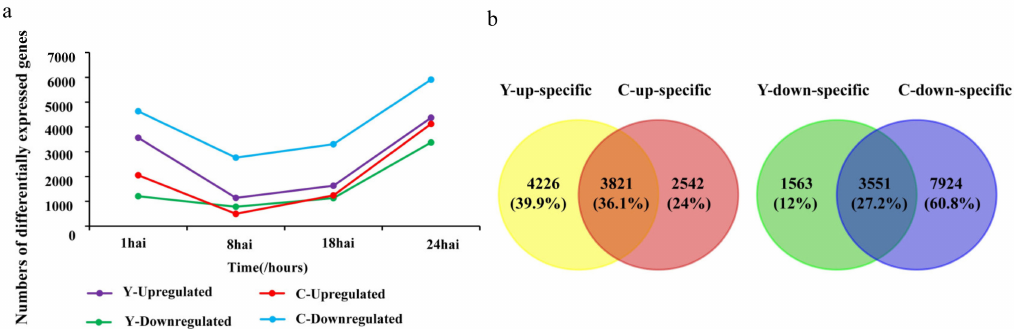
Figure 1. Di ff erentially expressed genes (DEGs) in CMPG1-V OE and susceptible receptor Yangmai 158 after Bgt infection. ( a ) DEGs of CMPG1-V OE and Yangmai 158 in di ff erent infection points. Purple and green represent upregulated and downregulated DEGs in Yangmai 158, red and blue represent upregulated and downregulated DEGs in CMPG1-V OE , respectively. ( b ) Venn diagram of upregulated and downregulated DEGs in CMPG1-V OE and Yangmai 158. (FDR ≤ 0.001; genes with the regulation ratio log ≥ 2 or ≤− 2 were